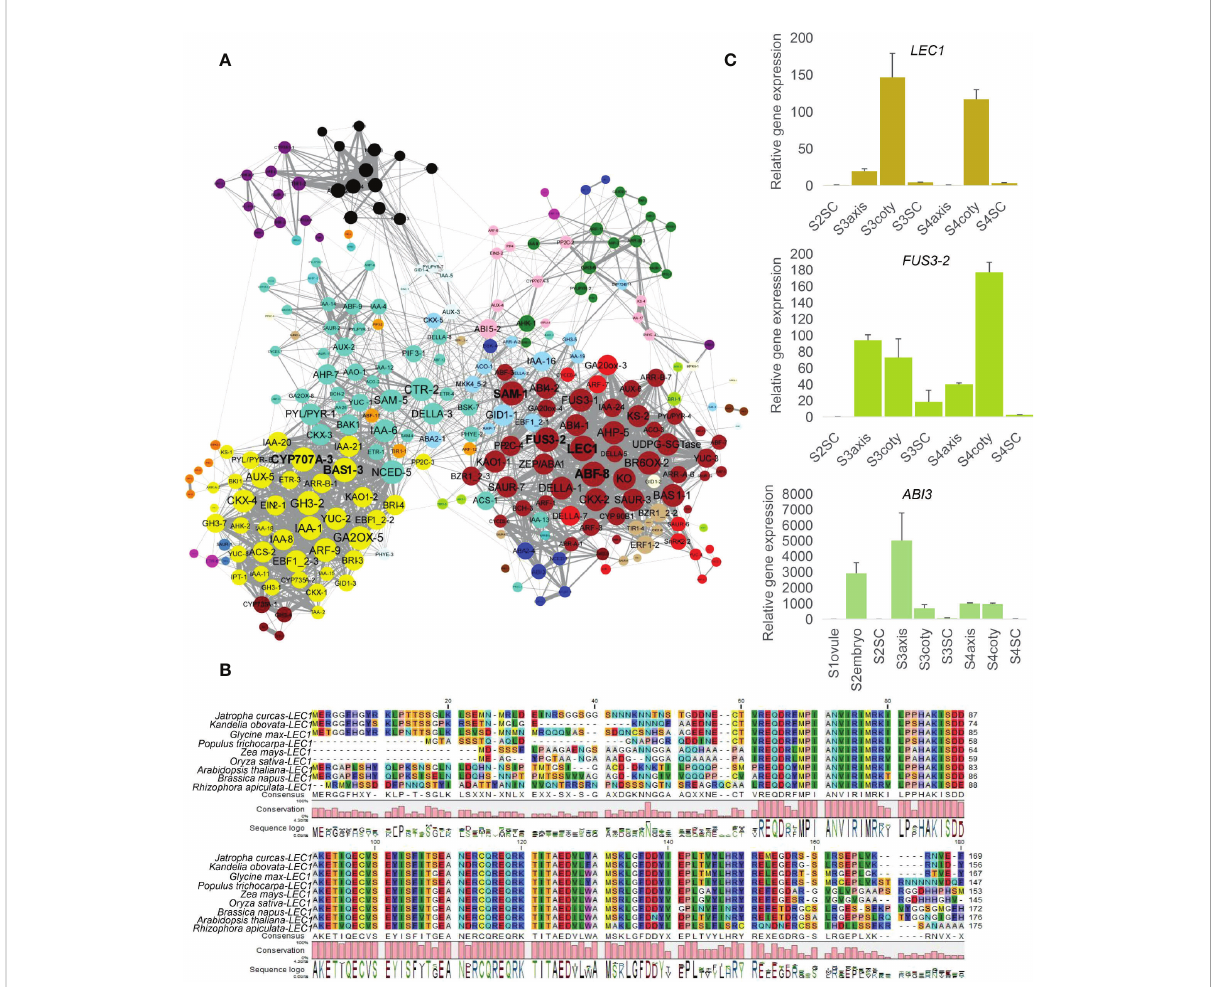
FIGURE 3 Network analysis of hormone-related genes and regulators. (A) Co-expression network of hormonally related genes whose nodes cutoff above p-value ≤ 0.01, color indicate the module attribute, the bigger circle size represents more connected genes. Yellow (lower-left), turquoise (upper-left), and brown (right) were bigger modules that survived under this fi ltered standard. Among them, six genes, namely LEC1, ABF-8, SAM-1, FUS3-2 in the brown module and CYP707A-3 , BAS1-3 in the yellow module, correlated with more genes. (B) LEC1 alignment in ( K ) obovata with eight dicot/monocot species showing conservative B domain from 62 to 149, numbers indicate amino acid position. (C) Expression levels of LEC1, FUS3 and ABI3 in